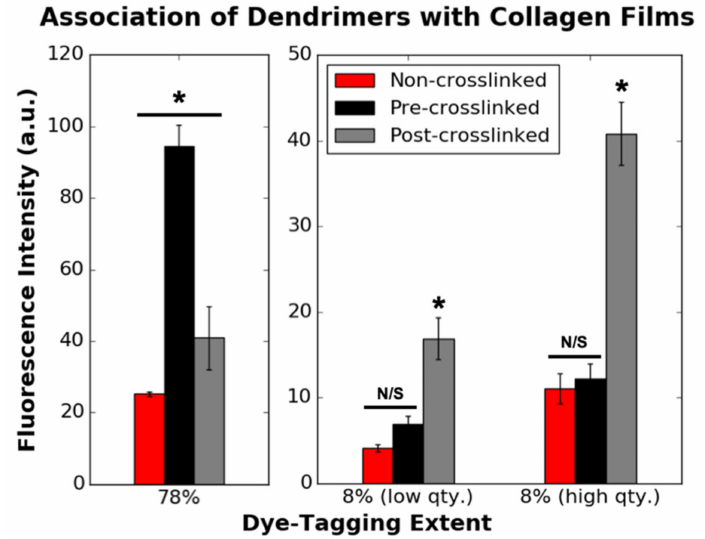
Figure 2. Initial association of 78% (0.77 µ g/mg loading concentration) ( n = 4) and 8% ( n = 12) dye-tagged dendrimers with non-crosslinked, pre-crosslinked and post-crosslinked films. Eight percent (low qty.) and 8% (high qty.) correspond to 0.74 and 1.49 µ g/mg loading concentrations ( µ g dendrimer per mg collagen), respectively. This data corresponds to the 0 h values in Figures 3 and 4. N/S denotes p ≥ 0.05. * indicates statistically significant difference ( p ≤ 0.001) from the two other substrate varieties with dendrimers with equivalent dye-tagging extents.